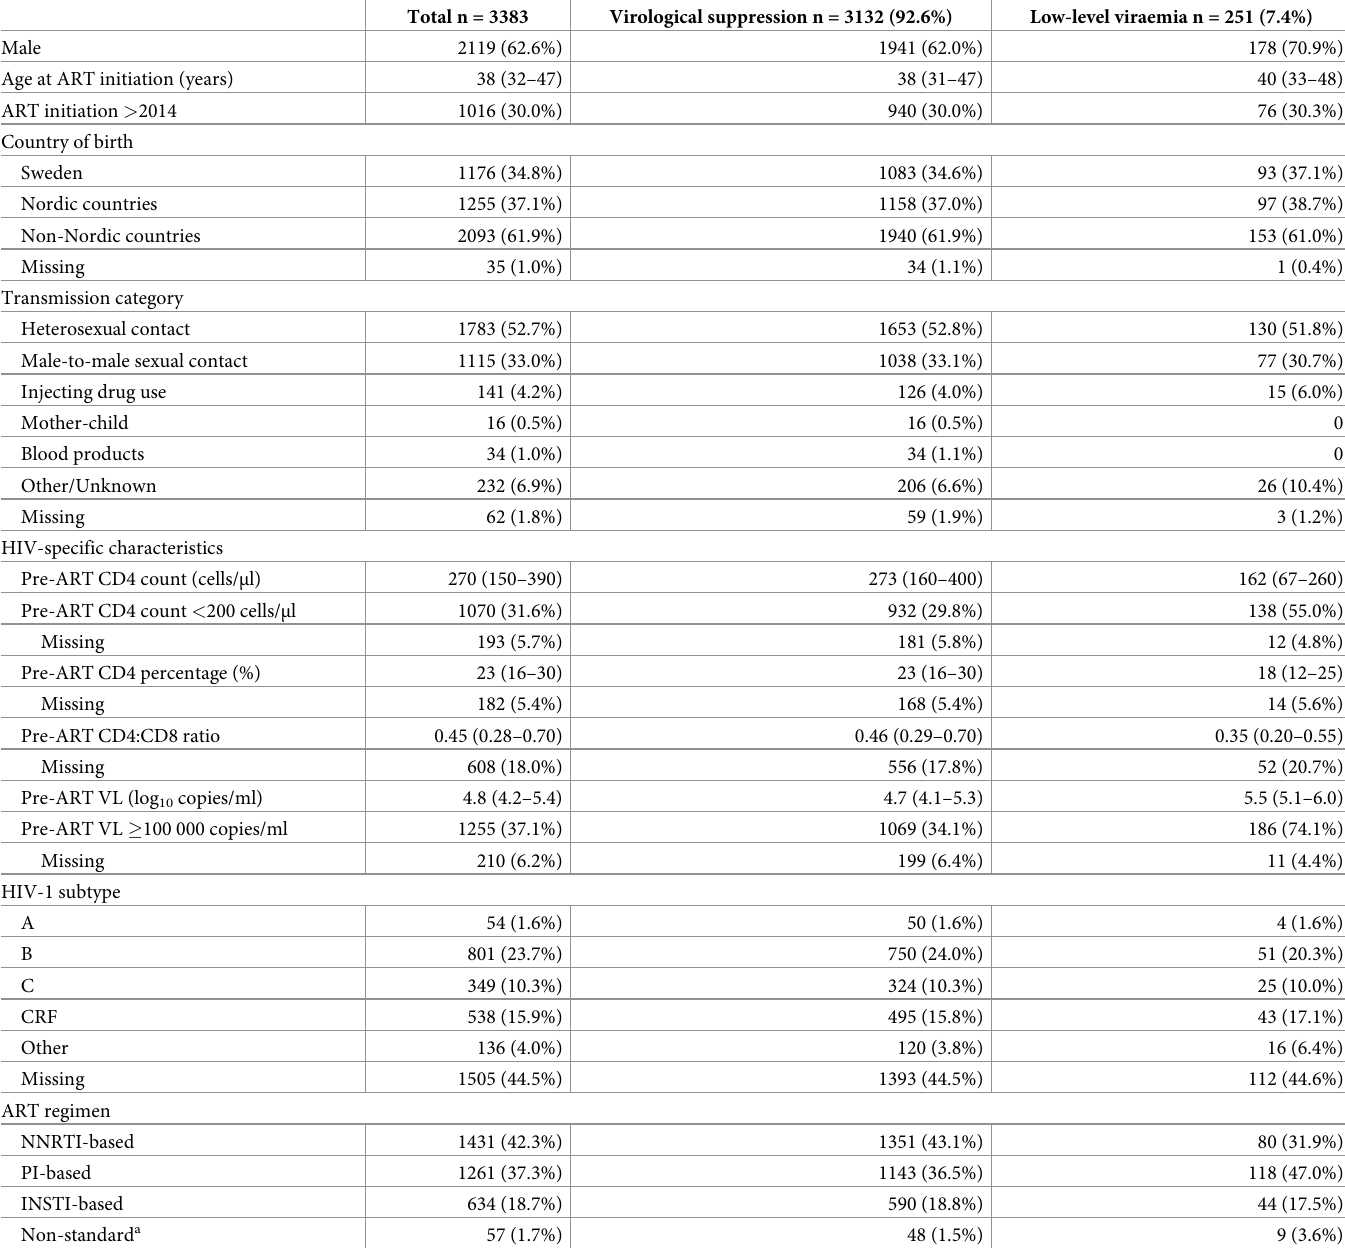
Table 1. Characteristics of study